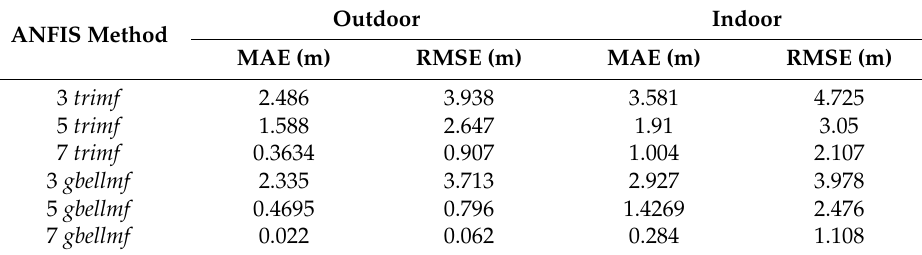
Table 2. Comparison of distance estimation accuracy based on